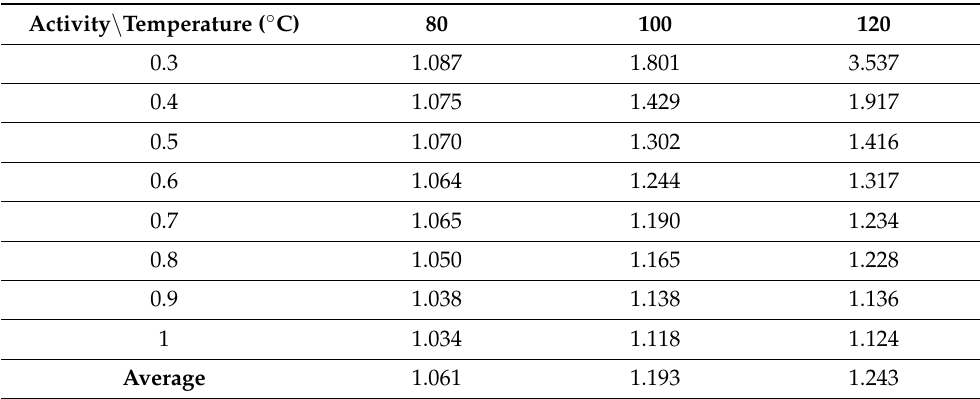
Table 6. Increase in Lambda between corrected and uncorrected